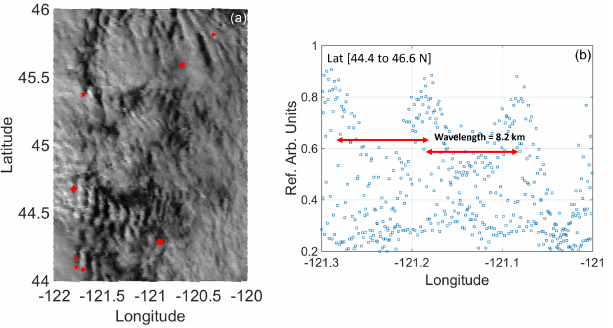
Figure 7. (a) GOES-14 satellite image on 23 September 2016, at 22:00UTC. The red dots represent the same locations as in Fig. 4. (b) The dots denote cloud reflectance in arbitrary units (counts or normalized data) covering latitude 44.4 to 46.6 ◦ N at